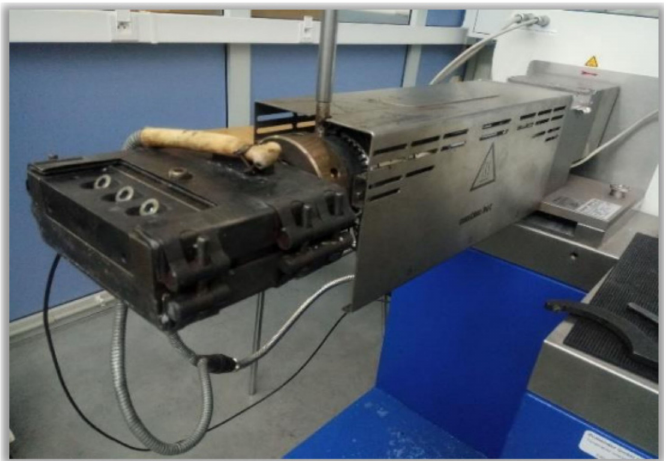
Figure 4. The single-screw extruder (Brabender ® , Duisburg, Germany), equipped with a narrow slot head (photo taken by authors of manuscript, Lukasiewicz Research Network, Poland,